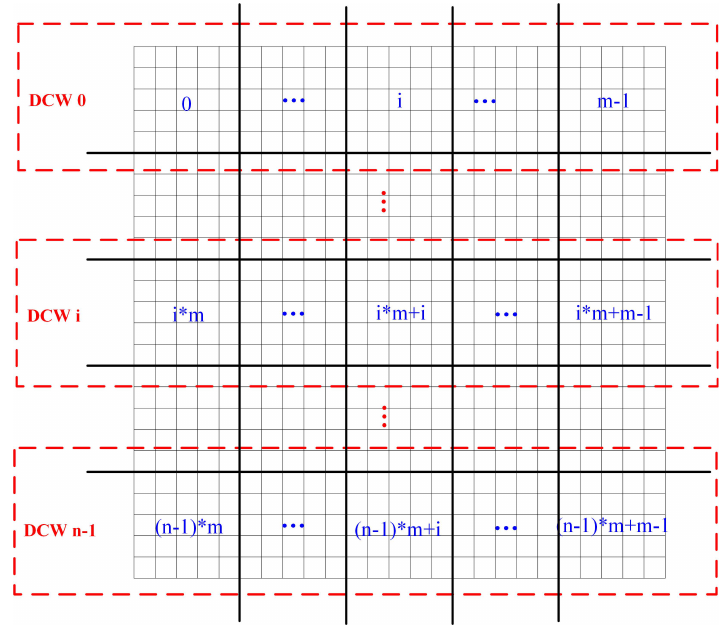
Figure 9. The forming principle of the